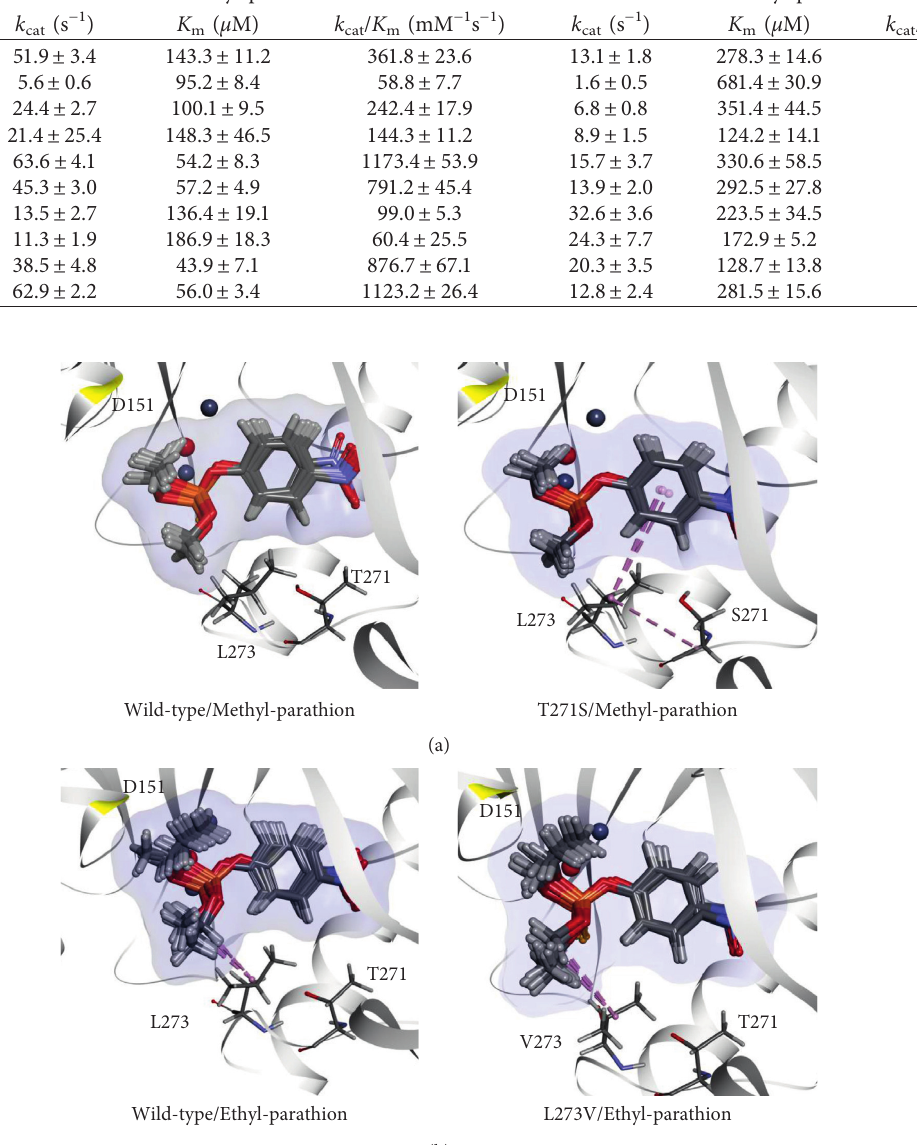
Figure 3: The complex conformation difference between MPH and its mutant. (a) The conformation of the enzymes with methyl-parathion. (b) The conformation of the enzymes with ethyl-parathion. The enzyme-substrate complex was constructed using CDOCKER of Discovery Studio, and the docking pose was further optimized by MD analysis. The mean conformation of MPH was shown in carton. During the MD analysis, ten random samples of each substrate were selected and presented in lines. The hydrophobic bonds between enzyme and substrate were indicated by dashed lines. The active residue D151 was marked in yellow. The oxygen atoms of water and Zn 2+ were shown as the red and deep purple balls, respectively.